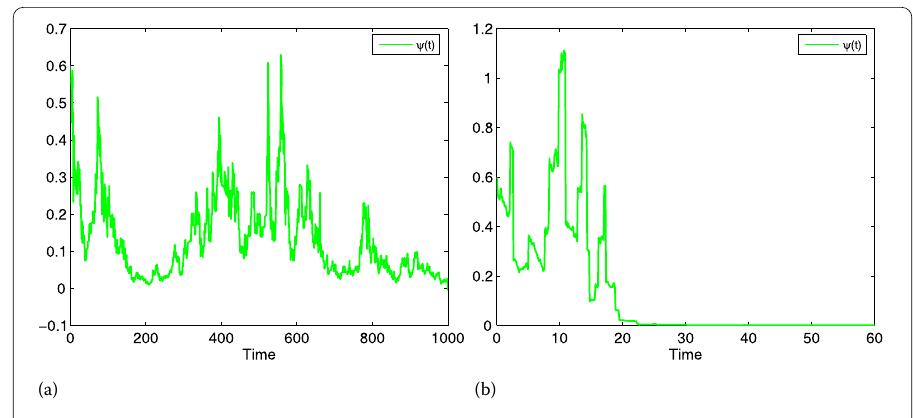
Figure 1 Solutions of Eq. (3) with r = 0.4, β 1 = 0.1, β 2 = 0.2, α = 0.3, ξ 2 = 0.2, X = (0,+ ∞ ), π ( X ) = 1, step size (cid:20) t = 0.001: ( a ) θ ( x ) ≡ 0.3504, hence μ = 0.05 > 0. This figure shows that the species is SP; ( b ) θ ( x ) ≡